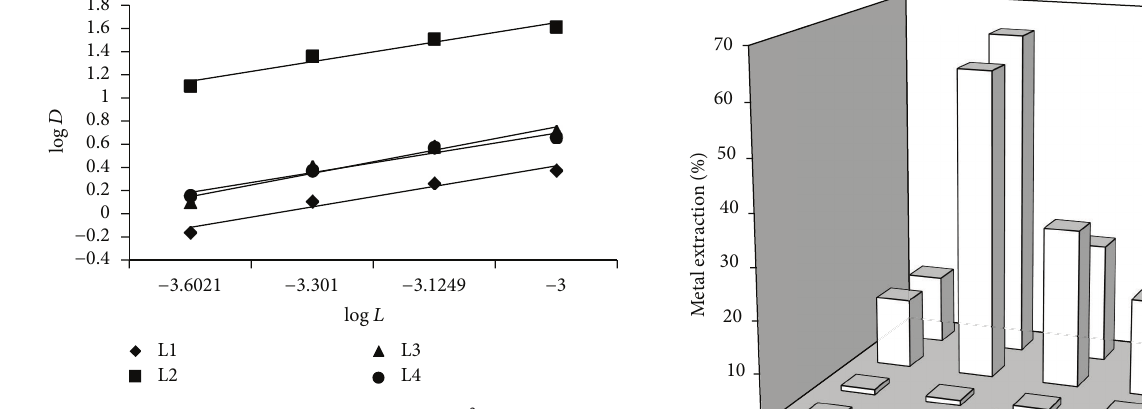
Figure 7: Plots of log 𝐷 versus log L for Cu 2+ of ligands.